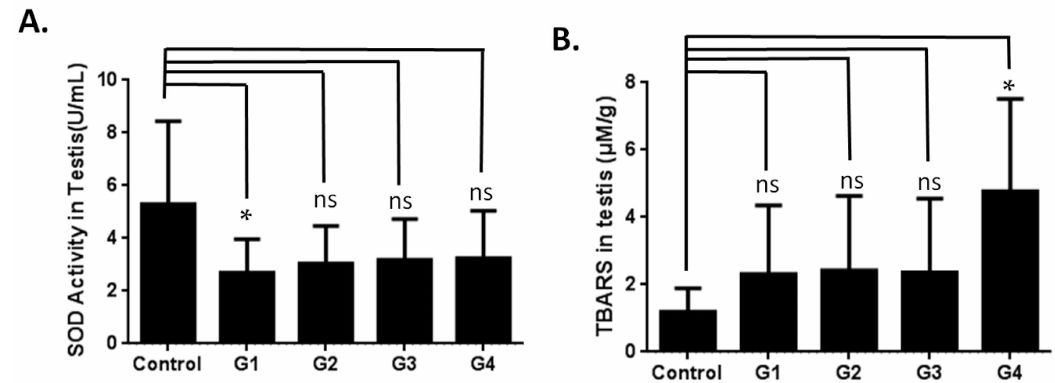
Figure 2. Effects of superoxide dismutase (SOD) activity and thiobarbituric acid reactive substances (TBARS) in testis from mice treated with D -Gal. ( A ) Mice injected with D -Gal l showed decreased SOD activity in testis compared to those administered PBS; ( B ) mice injected with D -Gal showed increased TBARS activity in testis (TBARS is a type of lipid peroxidation) compared to those administered PBS. One-way ANOVA test: bars represent the mean ˘ SD; Student’s t -test: “ns” denotes nonsignificant; * p <